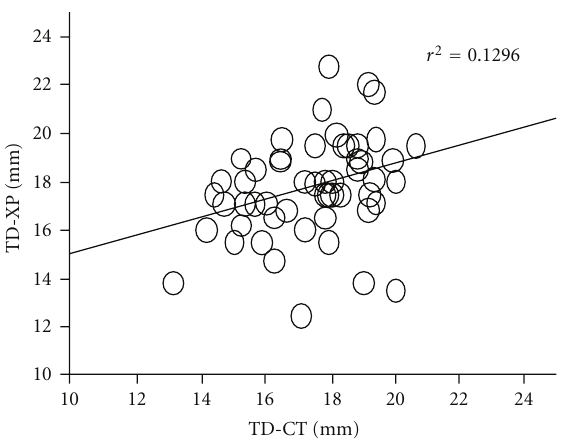
Figure 1: Correlation between TD-XP and TD-CT in male.